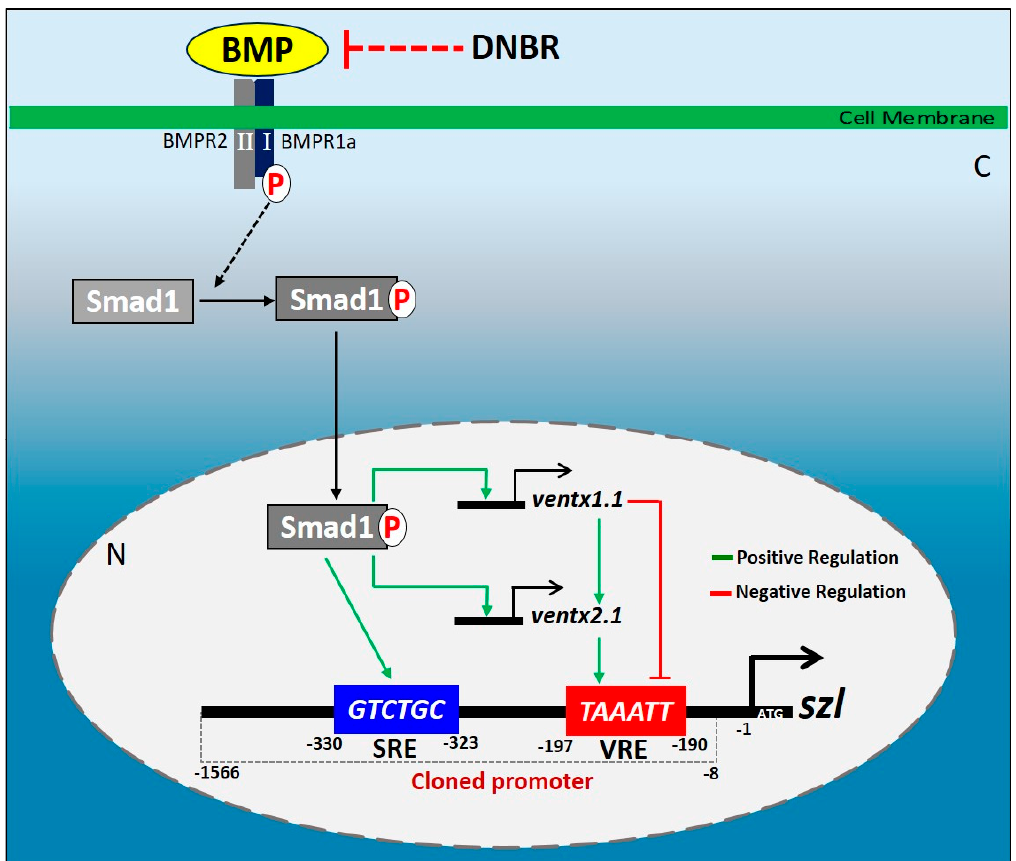
Figure 6. Proposed model of the szl transcriptional regulation by Bmp4 signaling via Smad1/Ventx1.1/Ventx2.1 axis. This schematic overview of szl transcriptional regulation during Bmp4 synexpression fashion is based on our findings above. Szl promoter has two types of Bmp4 response elements required for synexpression; they are the Smad1 binding response element (SRE) and the Ventx binding response element (VRE). Smad1 binds to SRE (reported here as TCTG )